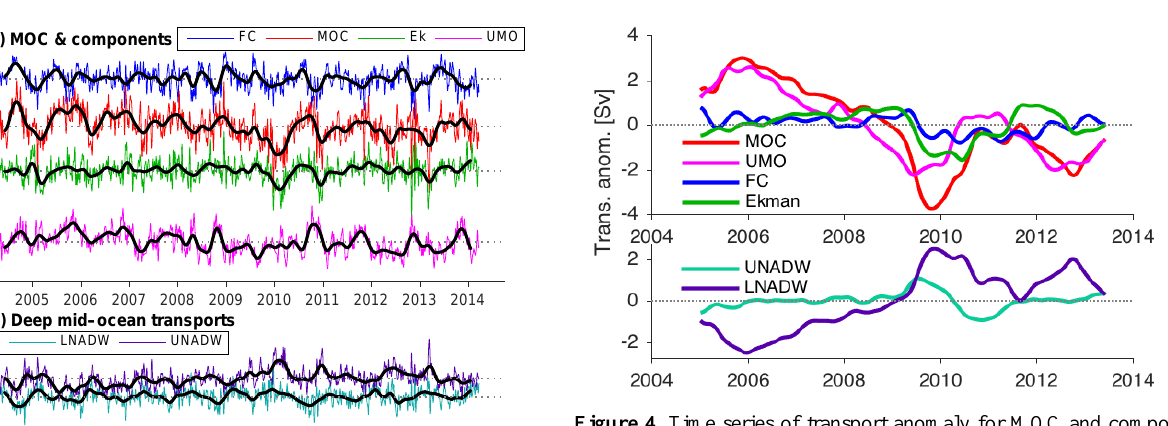
Figure 4. Time series of transport anomaly for MOC and compo- nents as in Fig. 2, deseasonalized and low-pass filtered with 1.5year filter. Table 1. Mean ± standard deviation of transports for the first 5 years and latter 5 years, where years run from 1 April–31 March. Standard deviations are calculated on the annual averages. Statistically signif- icant changes to the mean are indicated by bold, based on two-tailed t